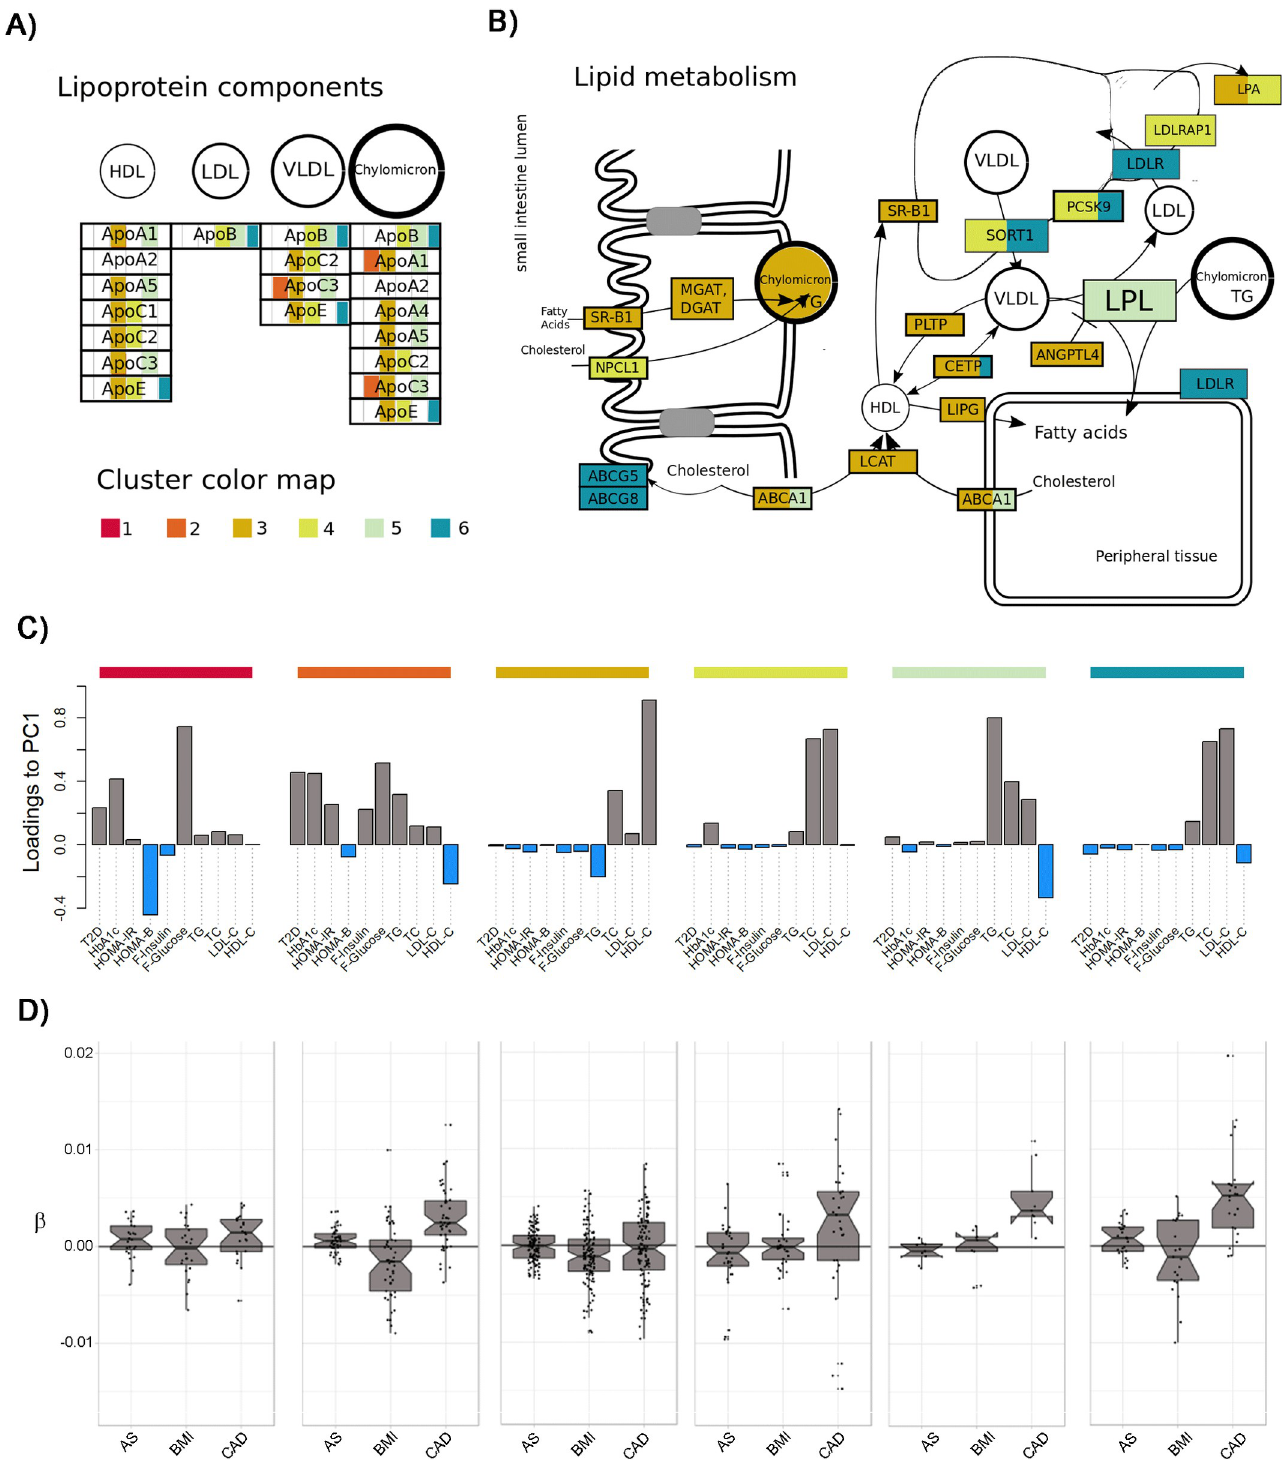
Fig 6. Mapping clusters to pathways. We projected cluster’s genes from the Metabolism phenotype set onto KEGG pathways and reconstructed a synthetic metabolic map. Panel A ) presents the results for the lipoprotein component and panel B ) for the lipid component. Gene names are highlighted by the colors of their associated clusters. When a gene is associated to several SNPs belonging to different clusters it is represented with several colors. To improve interpretation, we also present in panel C ) a proxy for the relative contribution of each phenotype per cluster, defined as the loadings of the first principal component derived from the matrix of Z-score for the subset of SNPs in that cluster. Finally, panel D ) shows the distribution of standardized beta for association between SNPs from each cluster and three diseases: any stroke (AS), coronary artery disease (CAD), and obesity (using body mass index as a proxy).